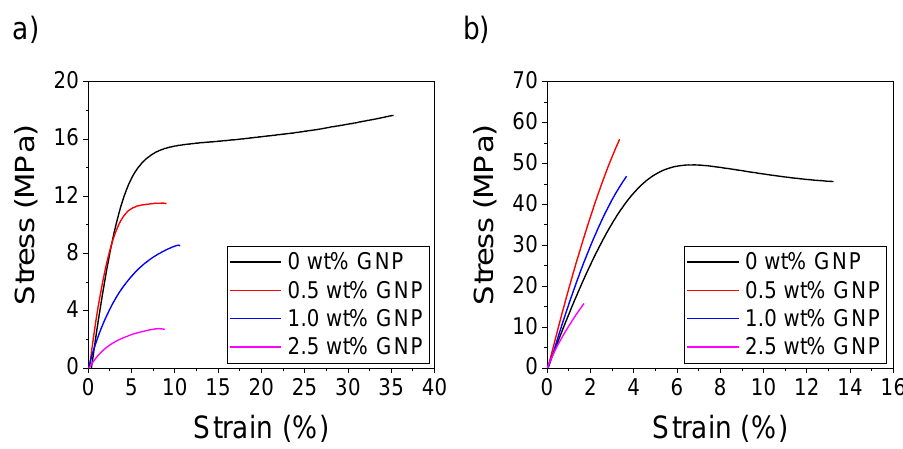
Figure 6. Representative strain–stress curves for the ( a ) green and ( b ) post-cured nanocomposites containing 0–2.5 wt % GNP.